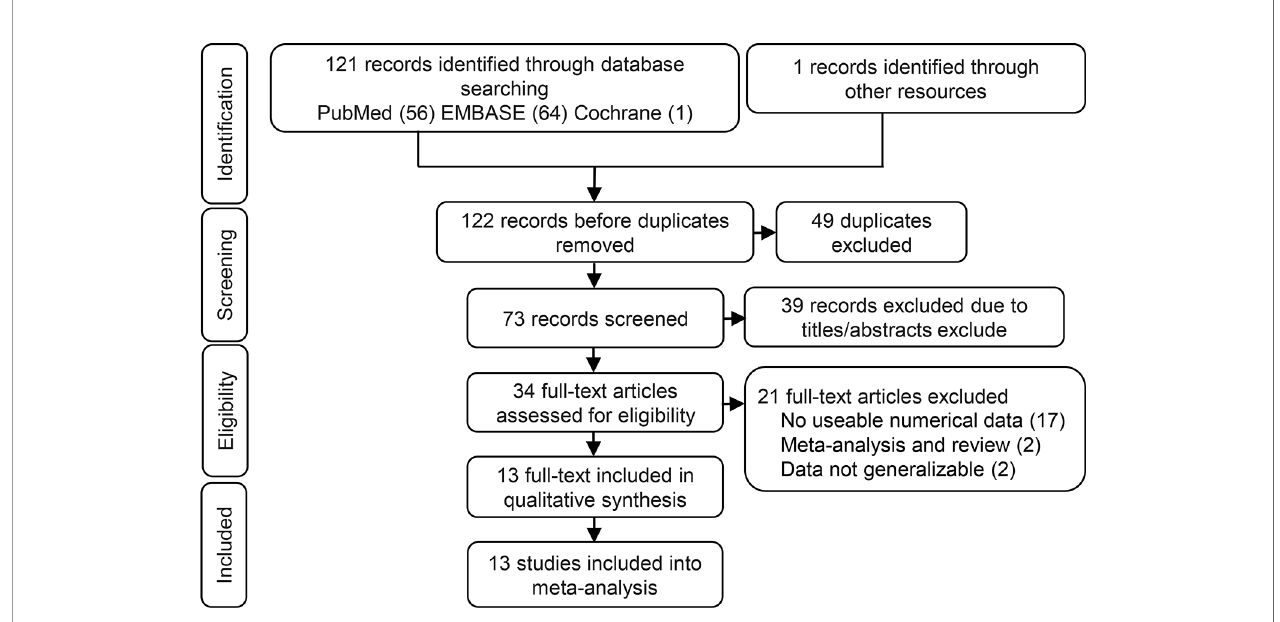
FIGURE 1 | Flow chart of the identi fi cation of eligible